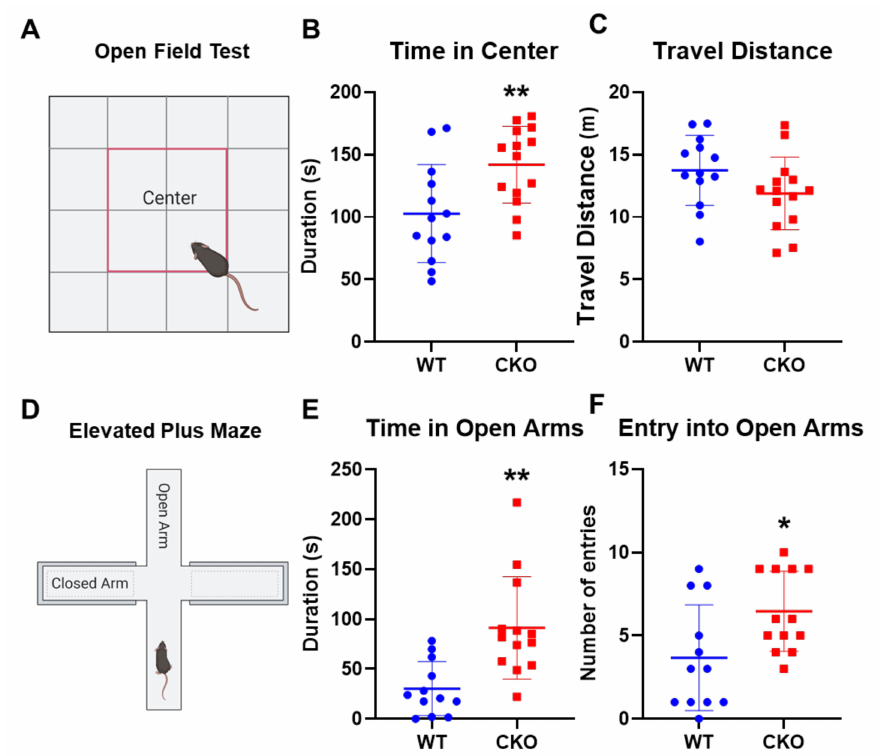
Figure 1. CKO mice exhibit reduced anxiety-like behaviors. ( A – C ) Open field test. The duration in the central area ( B ) and the total travel distance ( C ) in WT ( n = 13) and CKO ( n = 14) mice. ( D , E ) Elevated plus maze test. The duration in open arms € and numbers of entry into open arms ( F ) of WT ( n = 12) and CKO ( n = 13) mice. Results are presented as means ± SD, * p ≤ 0.05, ** p ≤ 0.01, compared with the WT